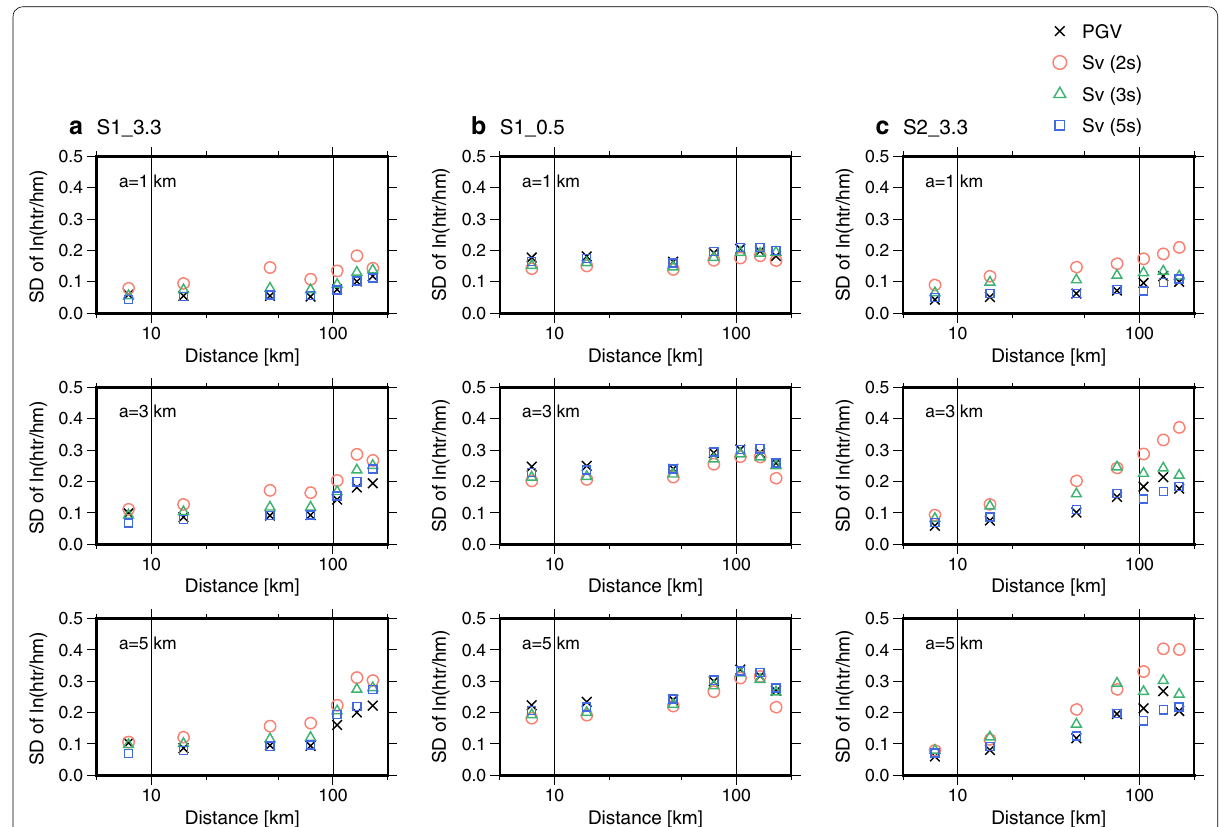
Fig. 9 Standard deviation of natural logarithm of heterogeneous-to-homogeneous ratio of PGV and Sv (periods 2, 3, and 5 s) plotted against epicentral distance. Standard deviation is computed for distance bins with intervals of 15–30 km. Results for heterogeneous velocity models with a 1, 3, and 5 km using source models a S1_3.3, b S1_0.5, and c =